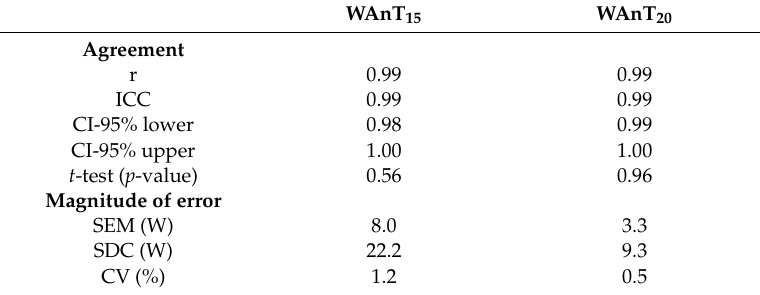
Table 2. Cross-validation analysis comparing the mean power (MPO) estimated by using the first 15 (WAnT 15 ) and 20 (WAnT 20 ) seconds of the test, and the 30 s MPO (reference criterion). WAnT 15 WAnT 20 Agreement r 0.99 0.99 ICC 0.99 CI-95%